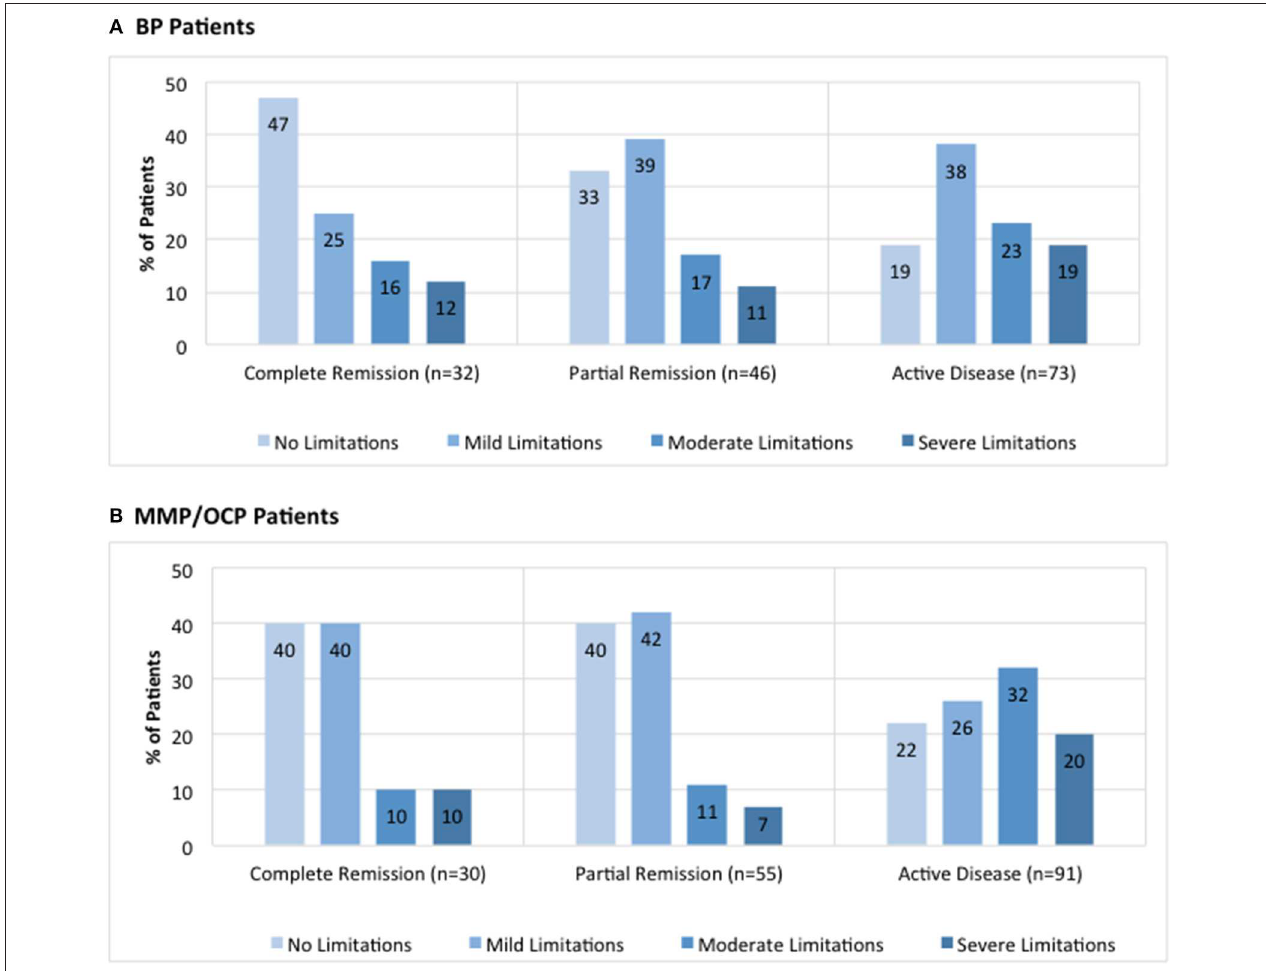
FIGURE 3 | Distribution of limitations in daily activities due to lesions by global illness activity. BP patients (A) and MMP patients (B) from the IPPF registry were categorized into different groups of global illness activity consisting of either complete remission, partial remission, or active disease. For each group of global illness activity, limitations in daily activity due to lesions classified as either no limitations, mild limitations, moderate limitations, or severe limitations were analyzed. Limitation in daily activities are listed as percent limitation among all patients in a given illness activity